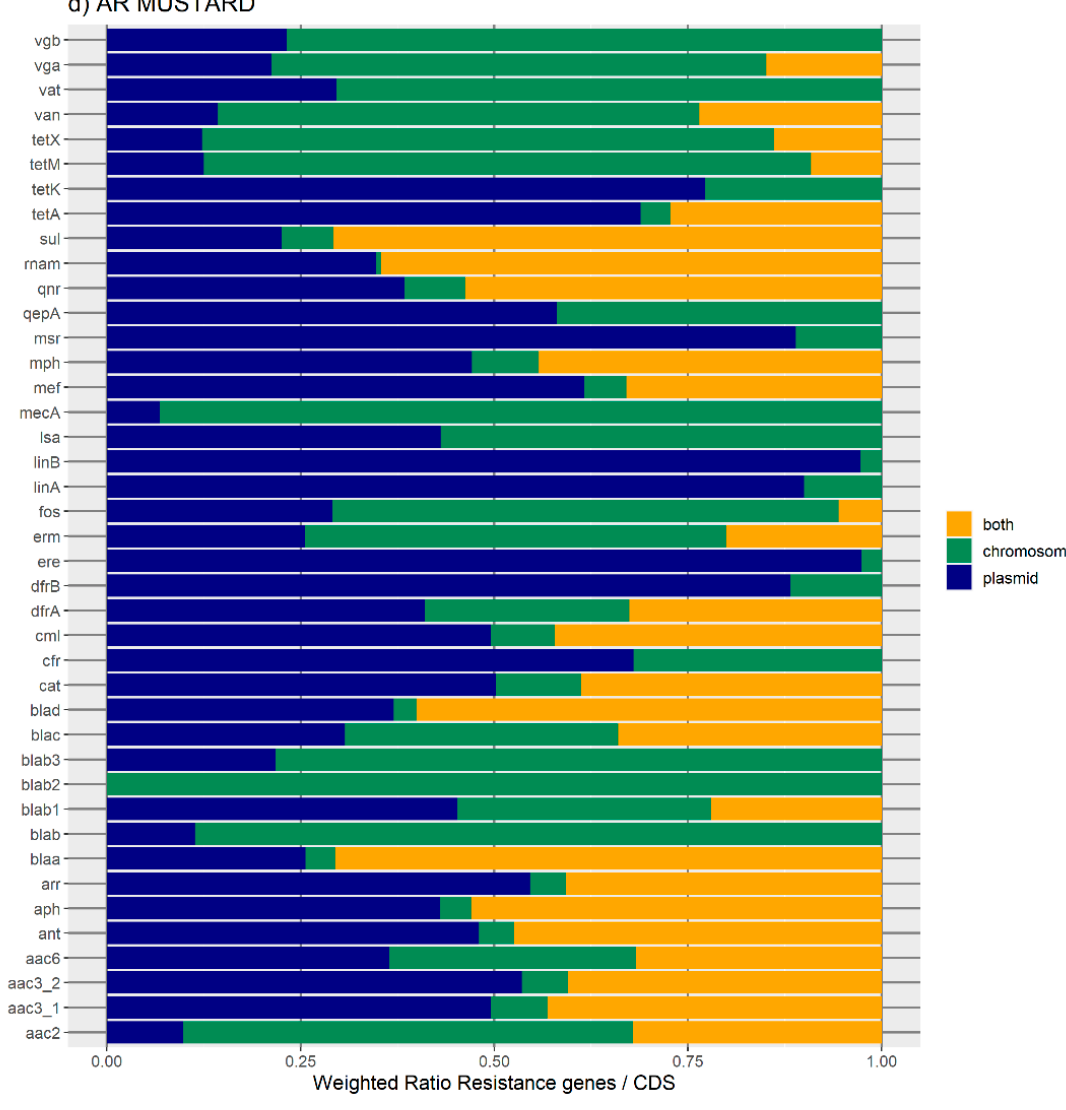
Figure 1. Bar plots and weighted bar plots of the number of antibiotic resistance orthologues. Because replicons vary in size, the number of resistance orthologues in each genome was divided by the amount of coding DNA sequences (CDS) in that genome (in that plasmid, in that chromosome, or in both). ( a , b ) Data from the ResFinder database; ( c , d ) data from the MUSTARD database. ( a ) For the ResFinder orthologues, the highest amount of antibiotic resistance orthologues is in the ‘both’ location (yellow). Beta-lactamase, sulphonamides, and disinfectant orthologues are more often (more than 50%) located in both replicons than in only a plasmid or the chromosome. ( b ) For the ResFinder orthologues, weighted bar plot shows that there are no fosfomicin, nitroimidazole, pseudomonicacid, fusidic acid, or glycopeptide orthologues in the ‘both’ location (yellow). Orthologues located in chromosomes (green) have a lower proportion compared to the other two genomic locations. ( c ) For the MUSTARD orthologues, there is a higher number of antibiotic resistance orthologues located simultaneously in both a plasmid and the chromosome (‘both’ location in yellow). There is a higher amount of blaa , rnam , and sul and orthologues. ( d ) For the MUSTARD database, there is a higher proportion of orthologues located in plasmids (blue). There is a lower proportion of orthologues located in ‘both’ a plasmid and the chromosome (yellow) than in a plasmid only or in the chromosome only. Moreover, 15 out of 45 orthologues (e.g., the orthologues of vgb , vat , or tetk ) are present only in a plasmid or in the chromosome (i.e., without a ‘both’